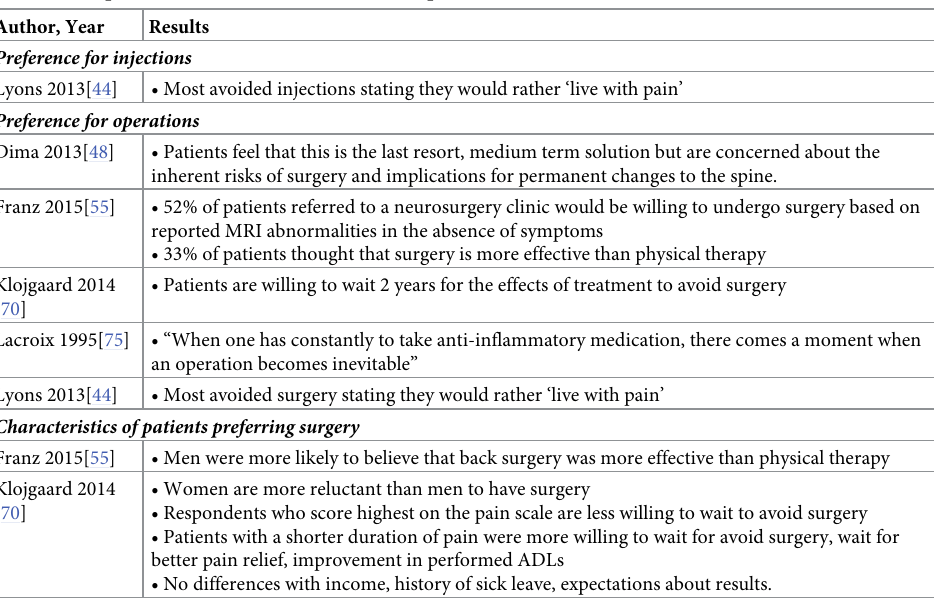
Table 4. The perceived need for interventional